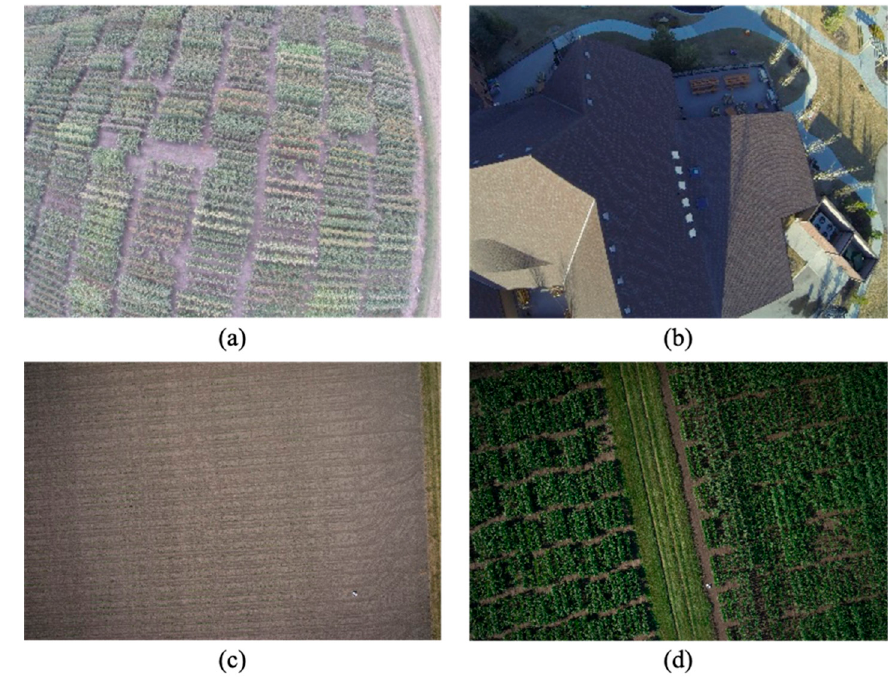
Figure 12. ( a ) Sample images from ( a ) Phantom2-Agriculture, ( b ) Phantom2-Building, ( c ) S1000- Agriculture-1, and ( d ) S1000-Agriculture-2